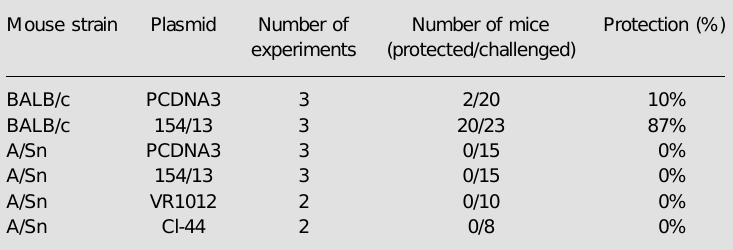
Table 2 - Survival of BALB/c and A/Sn mice after challenge with T. cruzi trypomastigotes. Mice were immunized with 4 doses of the indicated plasmid. Each dose consisted of 100 µg of DNA per animal. BALB/c and A/Sn mice were challenged with 6,500 and 250 T. cruzi trypomastigotes, respectively. Mouse